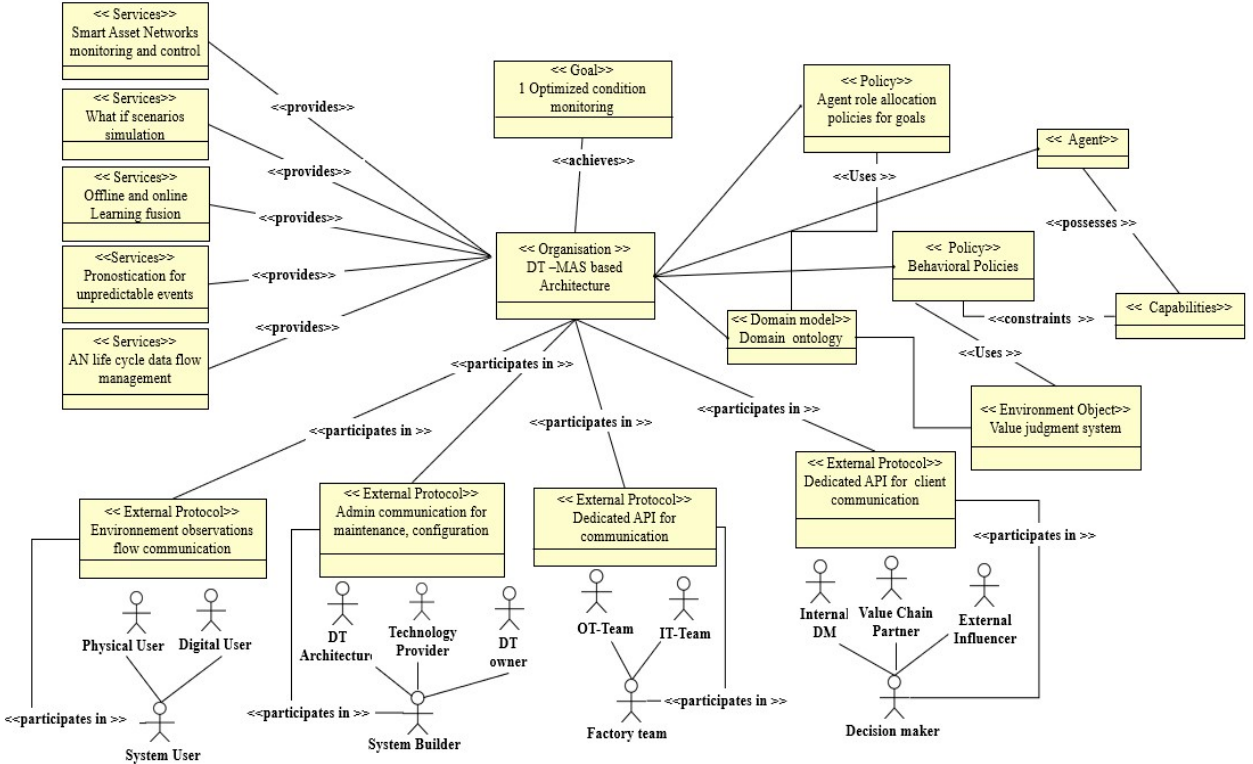
Figure 3. HT-OMASE networking view for the use case—organization model.